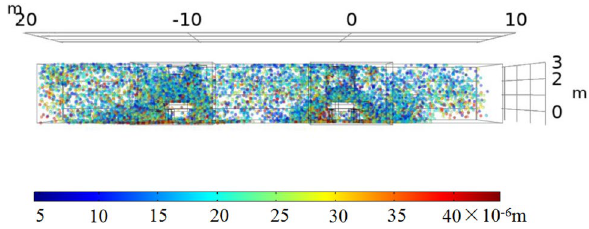
Figure 7. 26 Cross-sectional view of the particle size distribution.